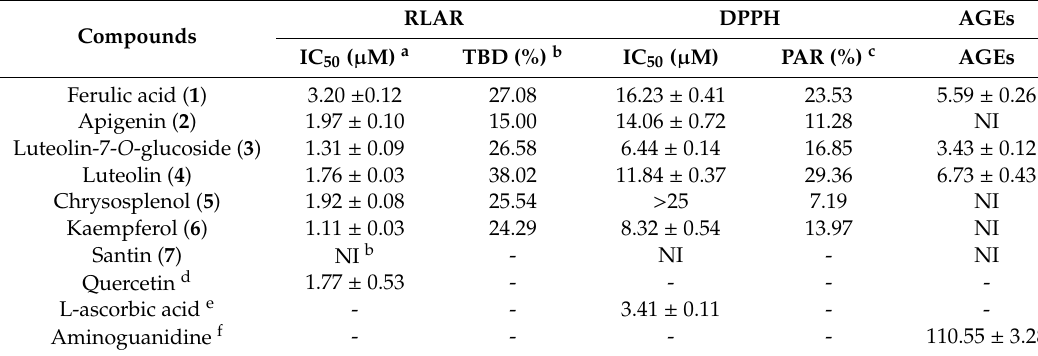
Table 3. Inhibitory e ff ects of compounds isolated from Tanacetum parthenium L. on RLAR, DPPH radical scavenging activity, and